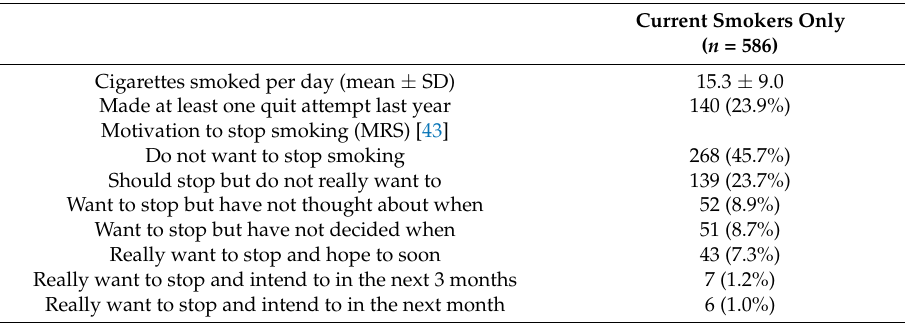
Table 2. Unweighted smoking characteristics of current